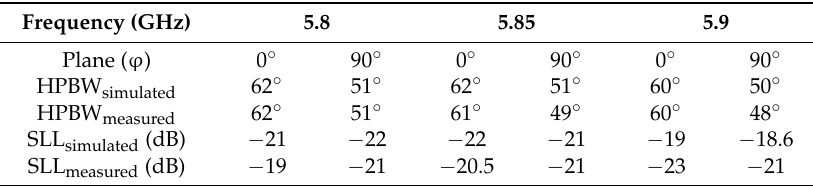
Table 2. Radiation pattern characteristics. HPBW: half power beam width.